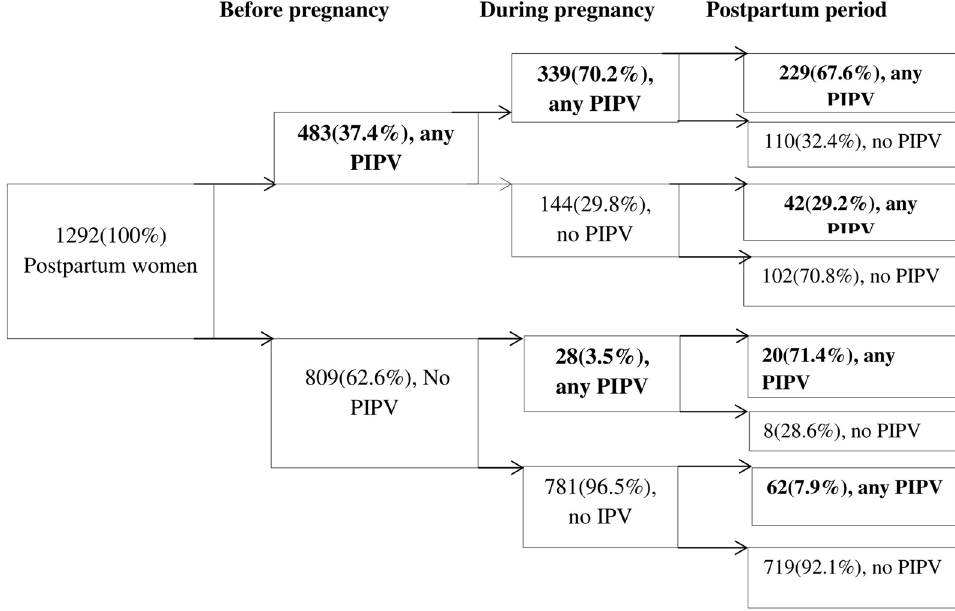
Figure 2. Continuities in perinatal intimate partner violence in Wolaita zone, Southern Ethiopia, 2020.